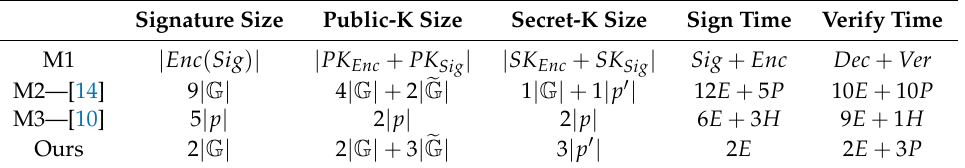
Table 1. Performance comparison. Sig is a signature algorithm, Ver is a verification algorithm, Enc and Dec are encryption algorithm and decryption algorithm, respectively, while E denotes exponentiation operation, P denotes pairing operation, H denotes hash operation. | p | , | p (cid:48) | , | G | and | (cid:101) G | are the size of the prime p , p (cid:48) and the groups G , (cid:101) G . Note that if we set the security parameter λ = 80, then we can implement a curve of type 3 Pairing where | p (cid:48) | , | G | and | (cid:101) G | are about 170 bits, 170 bits and 1024 bits, while method 3 uses finite field where | p | is much more bigger than 170 bits (about 1024 bits) when the security parameter λ = 80, see [13] for more details. Regarding method 2, we use BBS scheme [14], which is one of the most efficient group signature scheme to